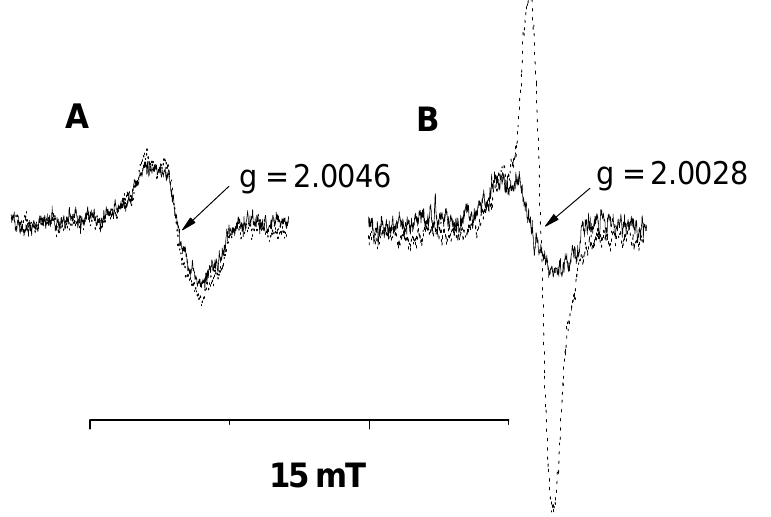
Figure 2. EPR spectra of control chloroplasts (A) and chloroplasts treated with 0.05 M of compound 3 (B) . Full lines were recorded in darkness. Dotted lines were recorded under irradiation (~400  E/m 2 s PAR) directly in the resonance cavity with a 250 W halogen lamp from 0.5 m distance through a 5 cm water